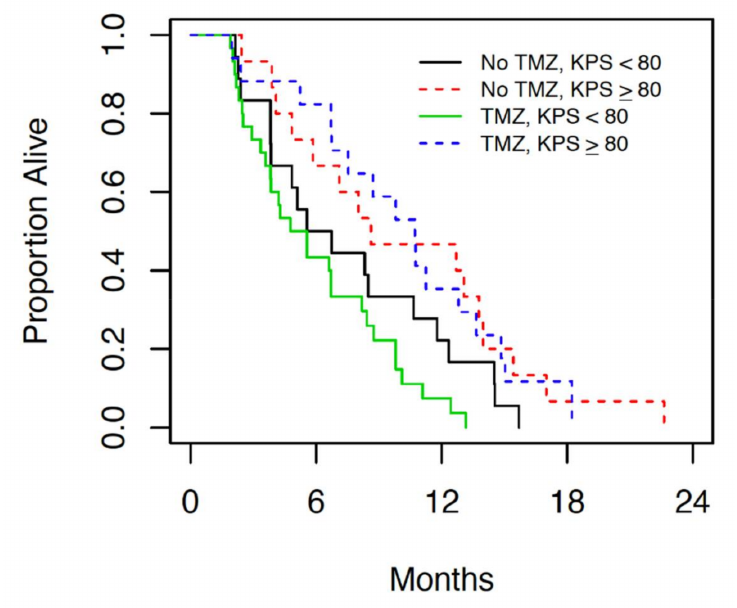
Figure 3. Median overall survival in patients who were treated with radiation alone (no TMZ) and chemoradiation (TMZ) subdivided further by KPS. When this patient population was compared in terms of neurologic decline following therapy, 10 or 32 (31%) of patients with KPS ≥ 80 showed neurologic decline within 1 month of treatment, while 23 of 48 (48%) patients with KPS < 80 showed neurologic decline within 1 month of treatment (Figure 4).